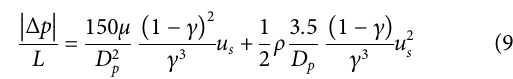
Frontiers in Energy Research |